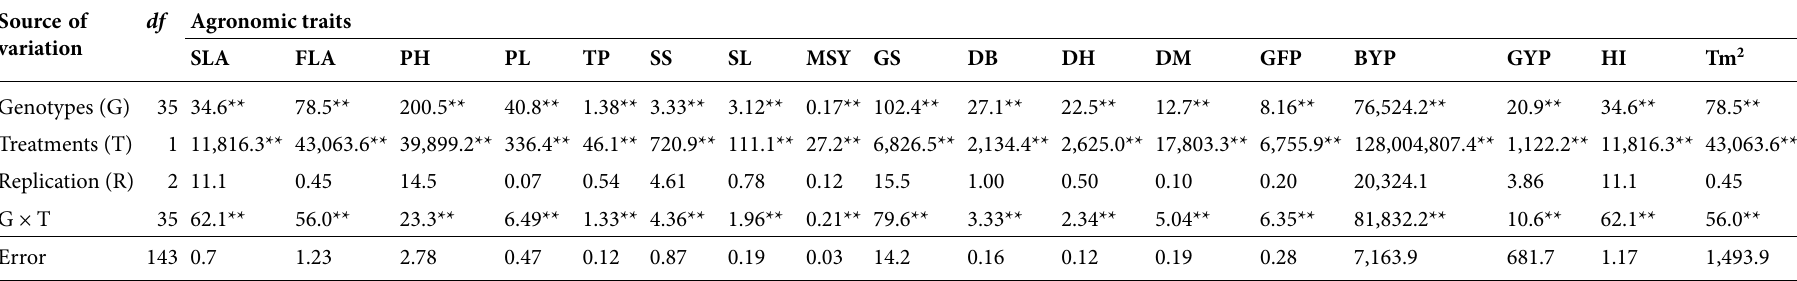
Table 3 Mean squares from combined analysis of variance (ANOVA) for agronomic traits of wheat genotypes in moisture stress (MS) and well-watered (WW) conditions. Source of df Agronomic variation